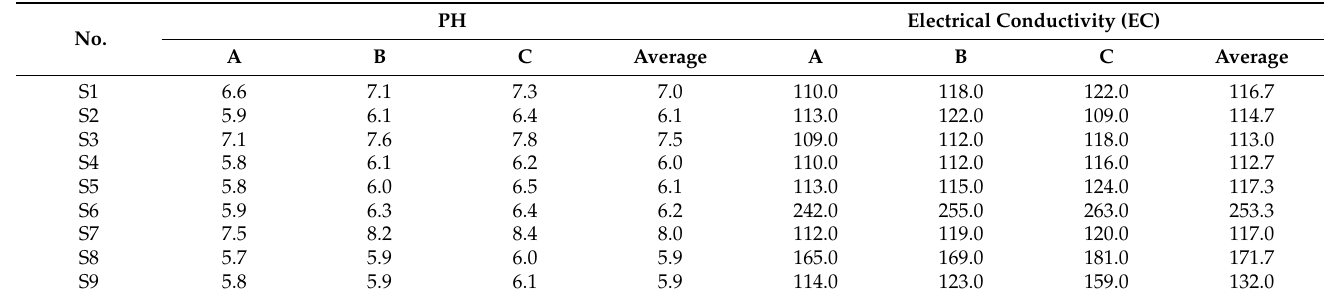
Table 2. PH and electrical conductivity of 9 mixed substrates.